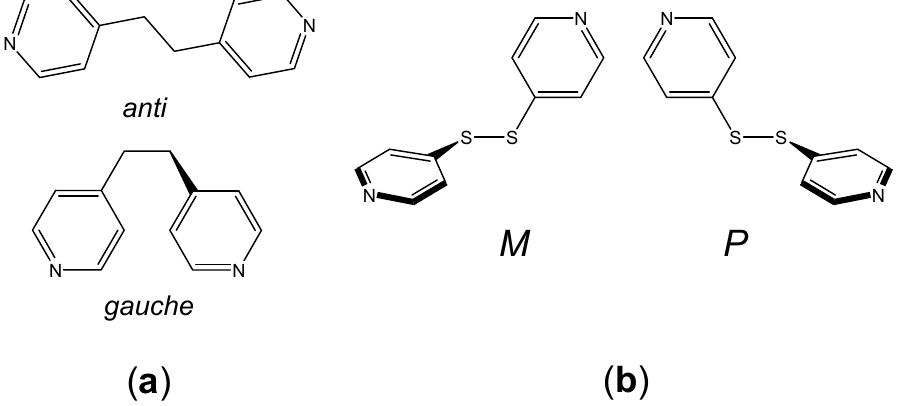
1. ( a ) Schematic drawing of the anti and gauche conformers of 1,2-bis(4-pyridyl)ethane; ( b ) Illustration of the two gauche conformational enantiomers of dtdp : left-handed M form and right-handed P form.